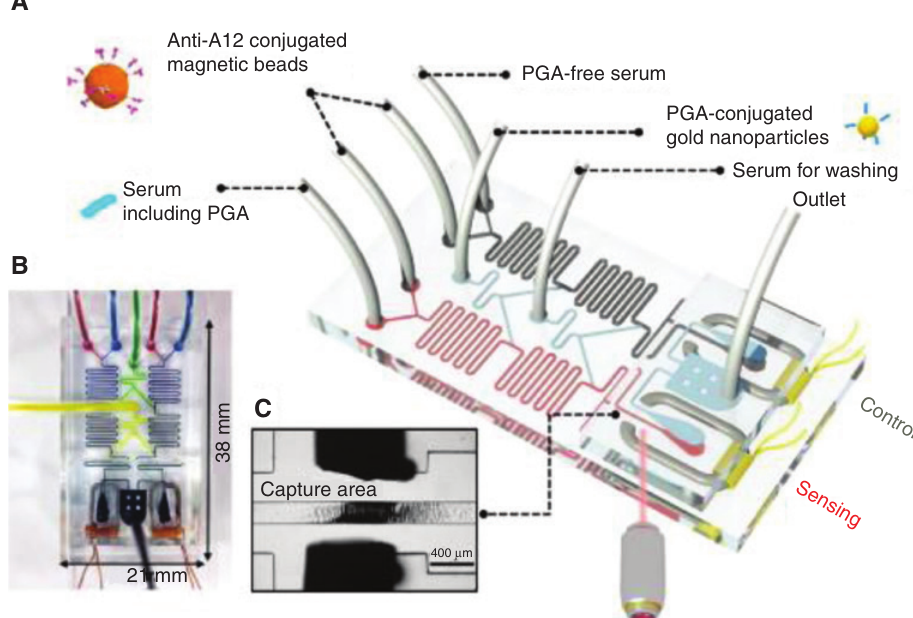
Figure 10: (A) Schematic illustration of the solenoid-embedded dual channel microfluidic sensor. The sensor is composed of two parallel channels: one for PGA sensing (light gray) and the other for control (dark gray). (B) Optical images of the solenoid chip filled with four differ- ent colors of inks. (C) Photograph of the capture area for magnetic immunocomplexes. Reprinted with permission from [186]. Copyright 2015 American Chemical